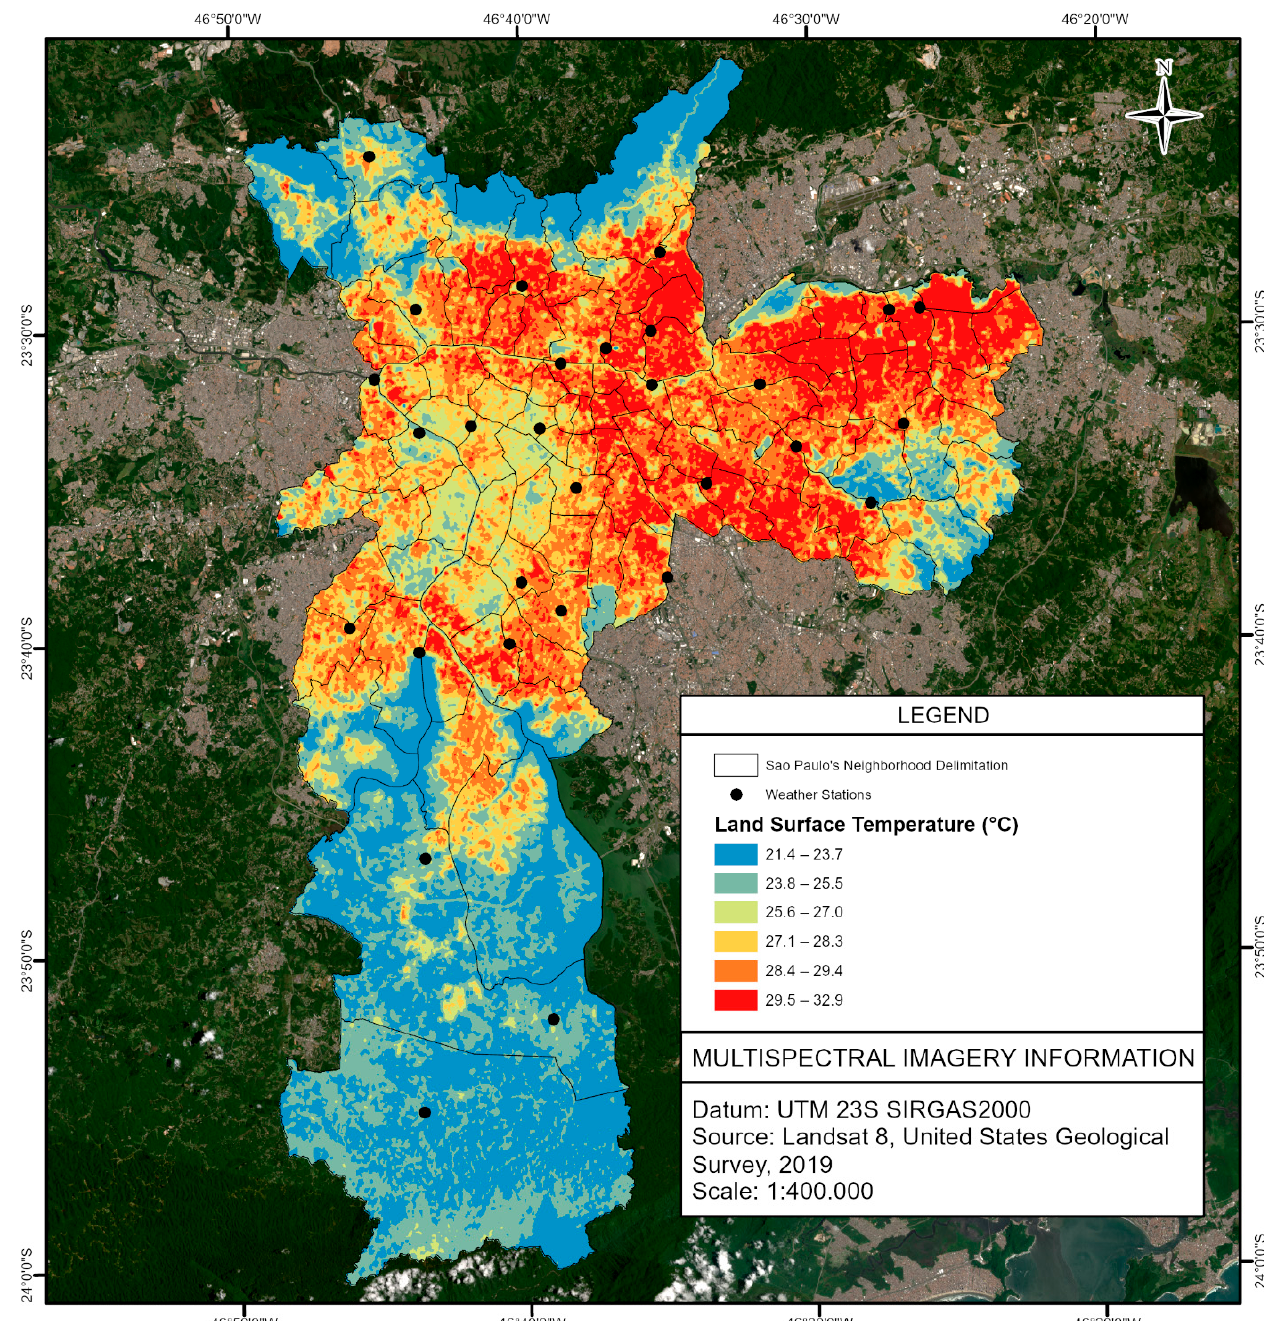
Figure 7. Land surface temperature (°C) in São Paulo City on 21 January 2019 at 1:04 PM using the split window algorithm. Source: Landsat 8, United States Geological Survey. Elaborated by authors (2021).